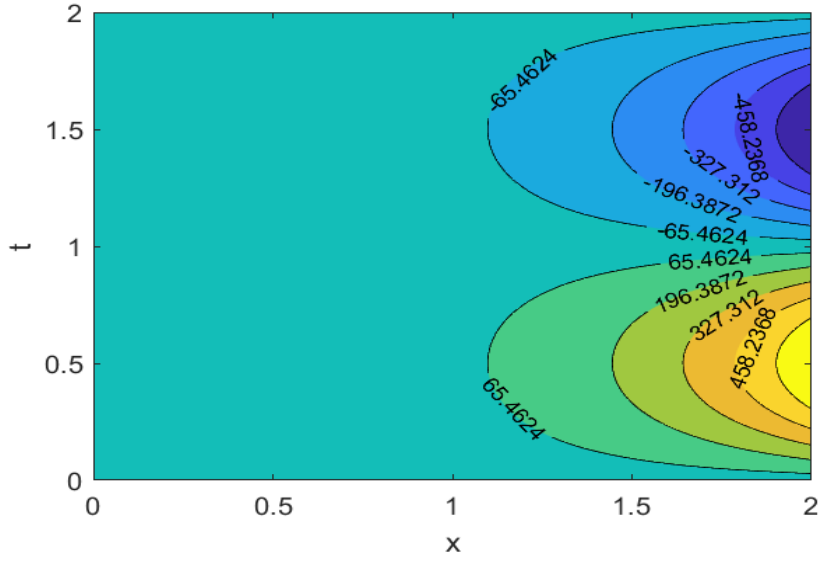
Figure 6. Contour plot of w ( x , t ) when α = 1.3, T = 2, L = 2, M = N = 256. Example 2. We choose ϕ ( x ) = sin ( π x ) , ψ ( x ) = 0 , T = 5 , L = 1 , α = 1.3 and x = 0.5 in (29). Suppose that the beam is in free vibration, that is, g ( x , t ) = 0 , different µ values were taken to verify the influence of material damping on beam vibration. The obtained results are shown in Figure 7, from which it can be concluded that the greater the damping coefficient of the material, the faster the vibration attenuation rate of the beam.